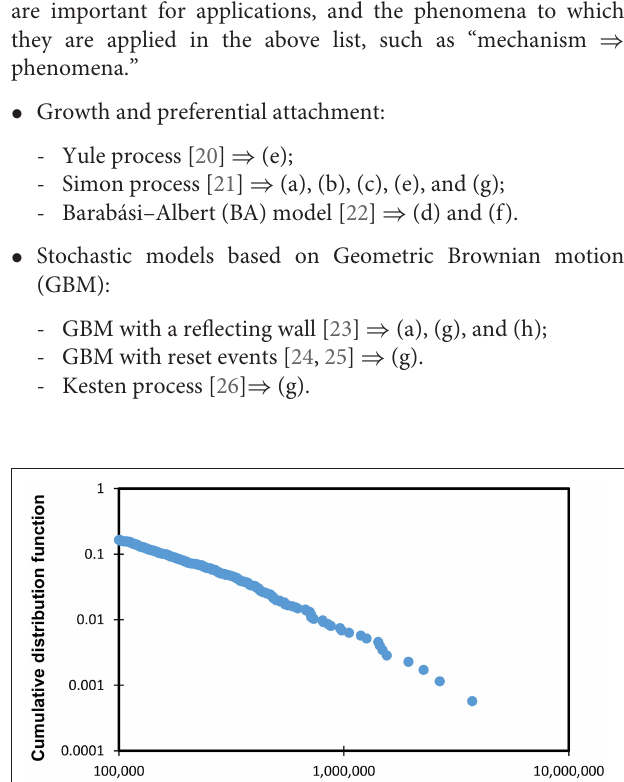
100,000. Data from the ≃